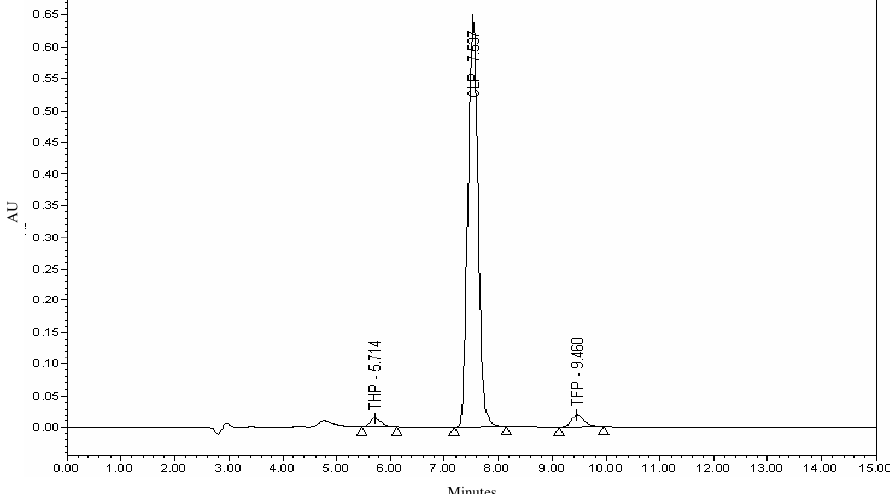
Figure 4. PDA peak purity for THP, TFP & CLP in standard preparation are express in fig (A), (B) & (C) respectively; the peak purity for THP in oxidative degradation, TFP in thermal degradation and CLP in acid hydrolysis are express in Figure (D), (E) & (F) respectively, were measured on WATERS TM 2998 PDA detector.